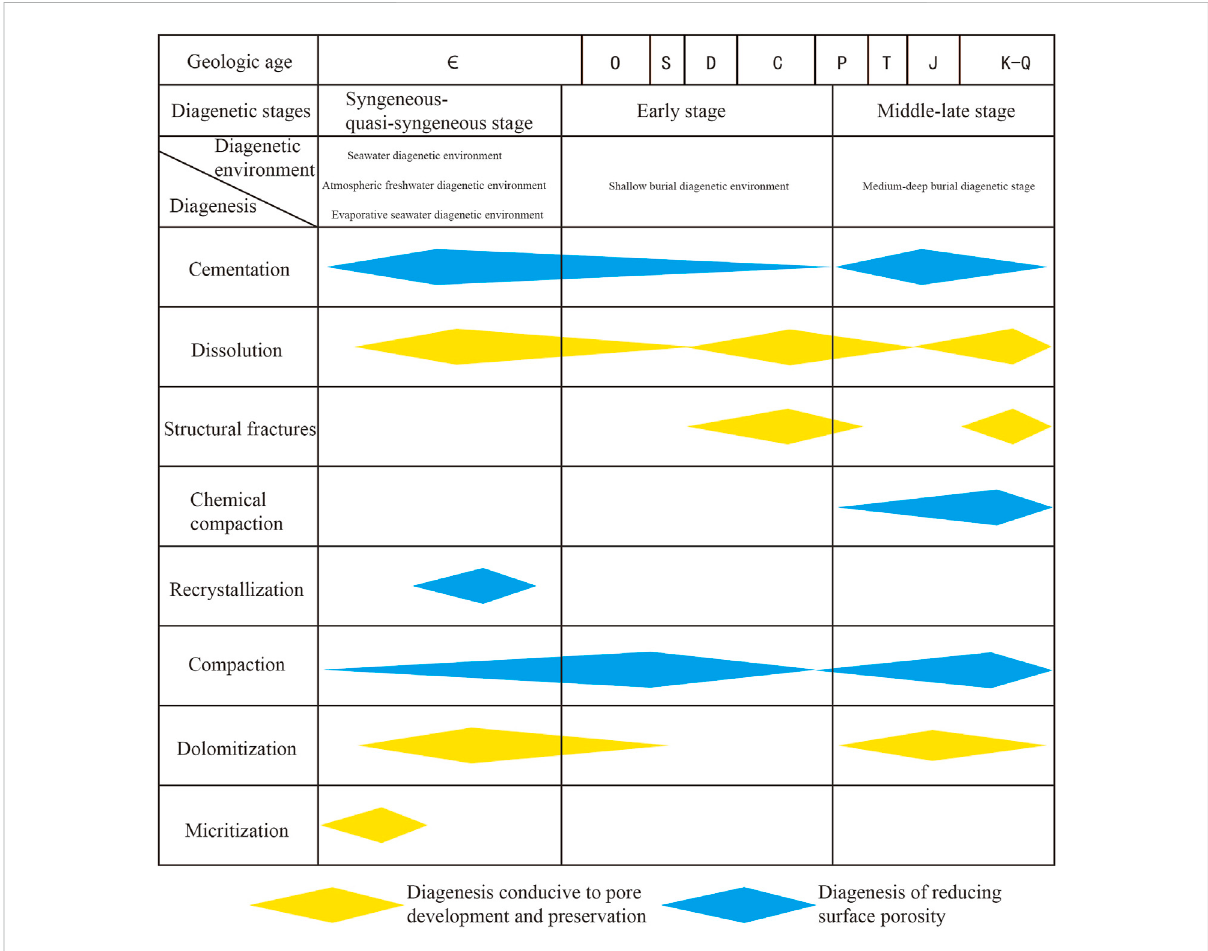
FIGURE 6 Construction results of the diagenetic sequence of the Cang 1 Member of the Canglangpu